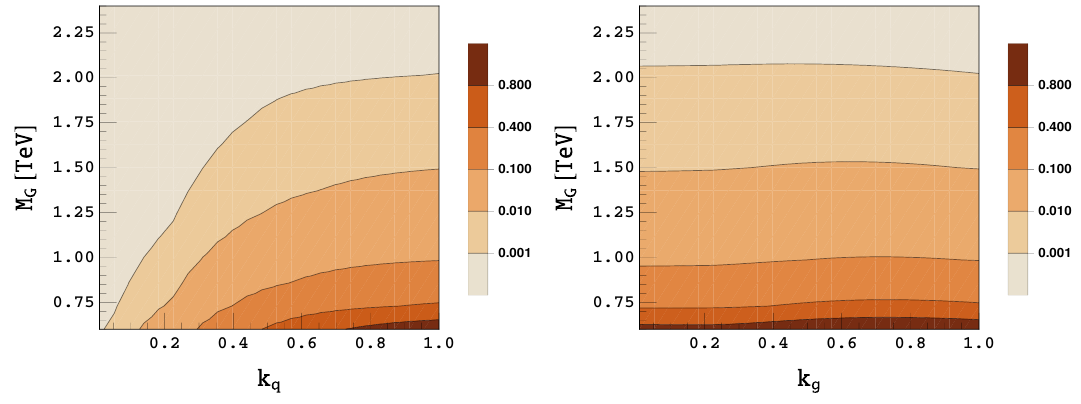
Figure 4 . The contour plot for mass of the spin-2 particle with coupling k q and k g for signal at NNLO+NNLL at Q = M G . The left panel shows the cross section (in pb ) for different M G and k q region while k g = 1 . 0 and the right panel shows the cross section for M G and k g region with k q fixed at 1 . 0 .